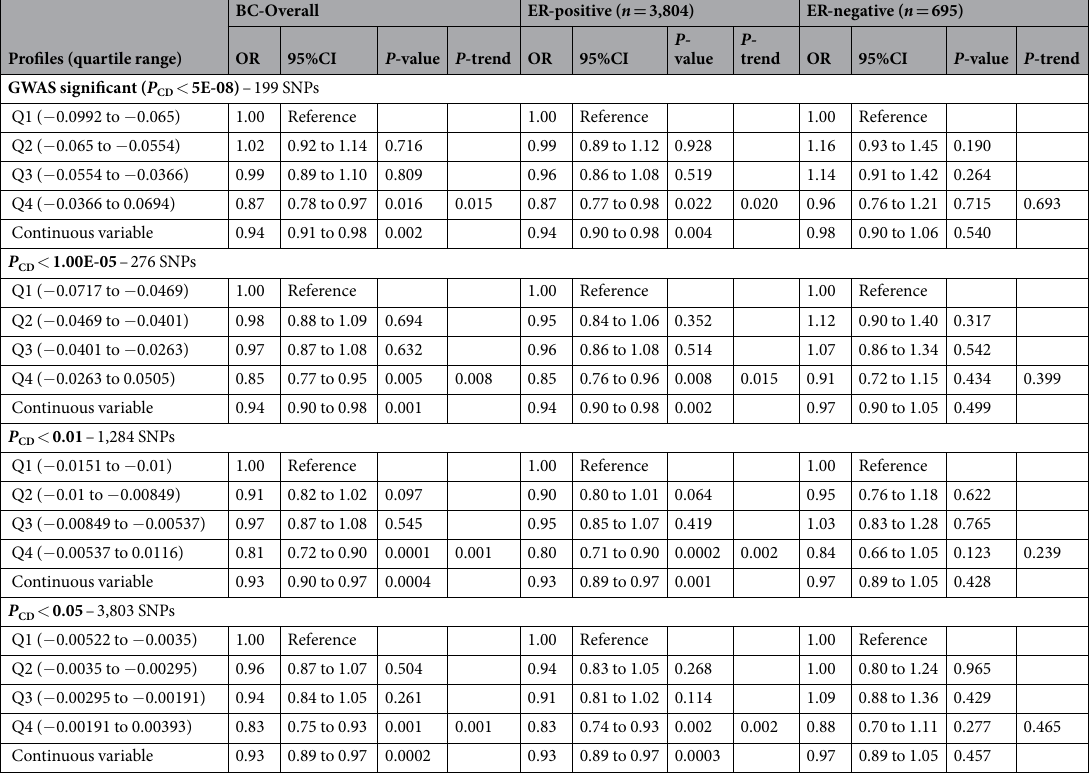
Table 2. Association of celiac-PRS profiles with breast cancer risk. Breast cancer risk association with celiac- PRS profiles including CD-SNPs with P-value less than four significance thresholds [ P CD < 5E-08, P CD <